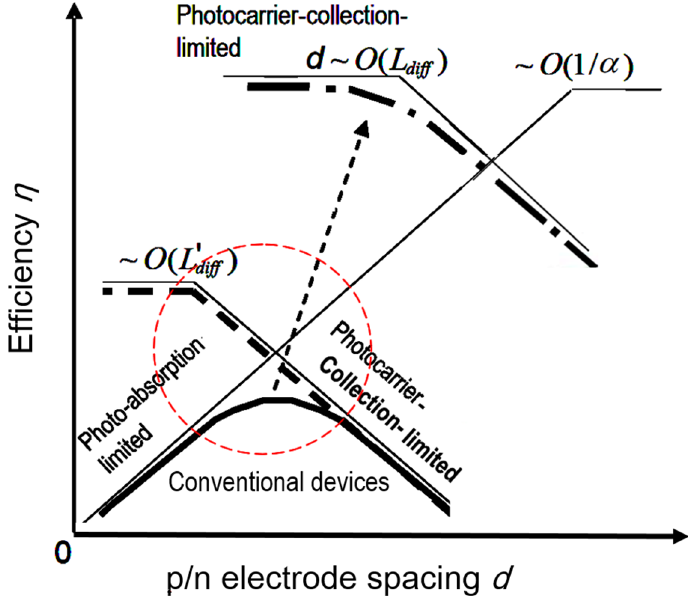
Figure 8. Expected d -dependence of efficiency in the orthogonal photon-photocarrier propagation solar cells. α is the absorption constant, and L diff ( L’ diff ) is the diffusion coefficient of photocarriers in the high (low) mobility material.